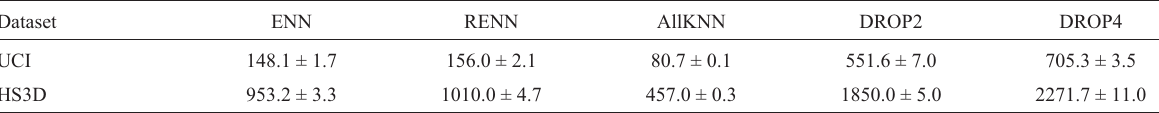
Table 3 - Pre-processing average time (in seconds) for a pre-processing parameter k = 3.